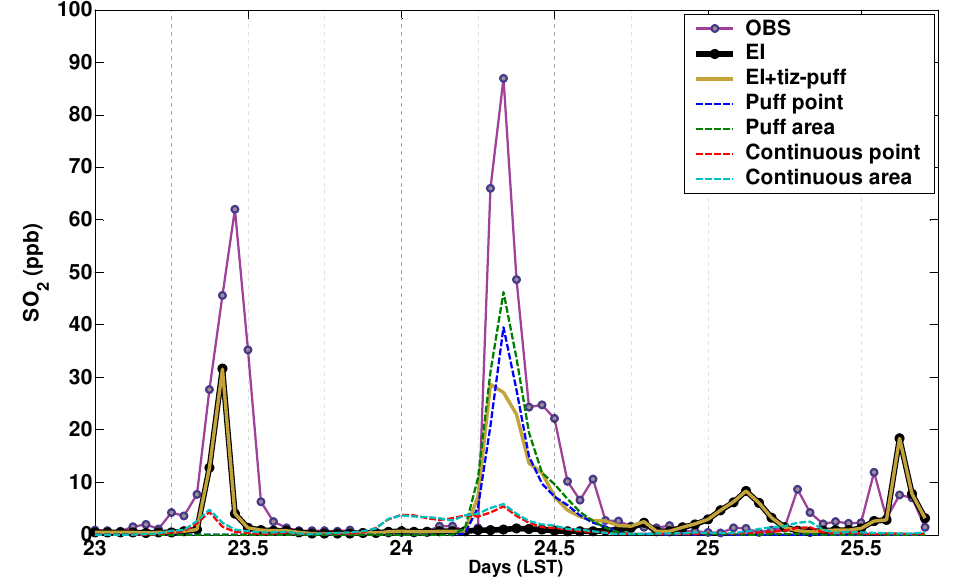
Figure 4. Model results of Tizayuca industrial emissions at T1. Dashed lines are forward dispersion simulations with WRF-FLEXPART taking the emissions as an episodic event (green and blue lines) and as a continuous emission (red and cyan lines). Solid lines are WRF- Chem simulations without including the Tizayuca episodic event in the official 2006 EI (thick black line) and after including the Tizayuca episodic event in the EI (golden